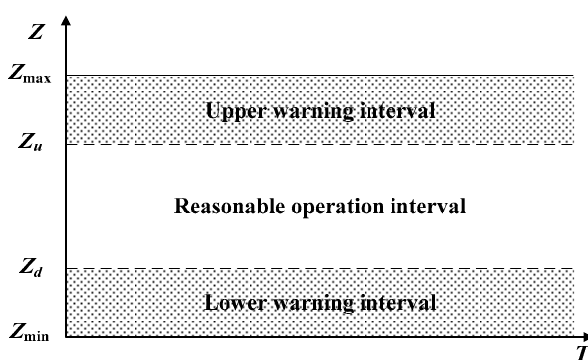
Figure 3. Schematic diagram of the reasonable operation interval of water level.